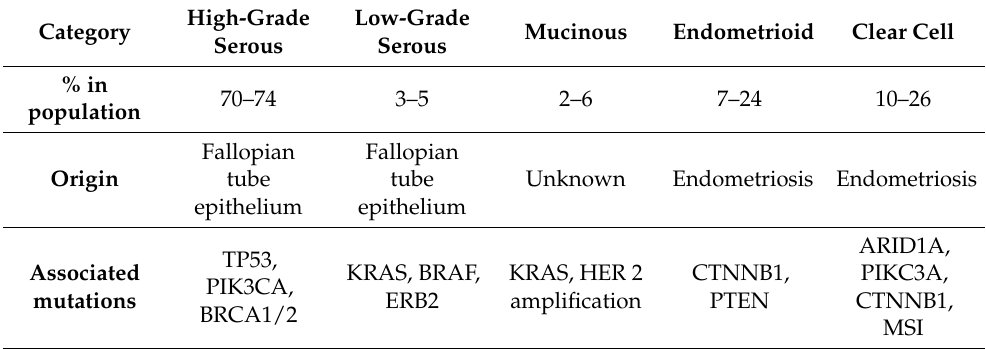
Table 1. Major subtypes of epithelial ovarian cancer and mutations associated with them.